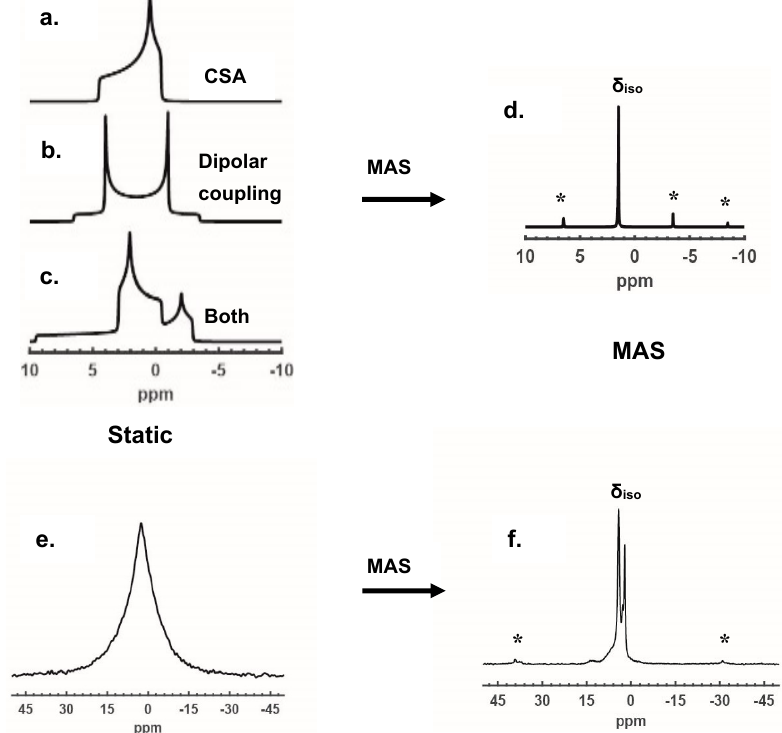
Figure 1. ( a – c ) Simulated powder lineshapes of static spectra ( 13 C at 9.4 T) with 3 kHz chemical shift anisotropy (CSA) and 5 kHz dipolar coupling interactions introduced separately or together as indicated in the figures. With 5 kHz magic-angle spinning, all inhomogeneous patterns in ( a – c ) break up to an isotropic peak and spinning sidebands, as shown in ( d ). ( e , f ) show the suppression of dipolar coupling and CSA for a dehydrated zeolite HZSM-5 catalyst in 1 H NMR by magic-angle spinning (MAS). The spectra of ( e , f ) were acquired at 9.4 T, where ( f ) was acquired at spinning frequency of 10 kHz. Spinning sidebands are denoted in “*”.